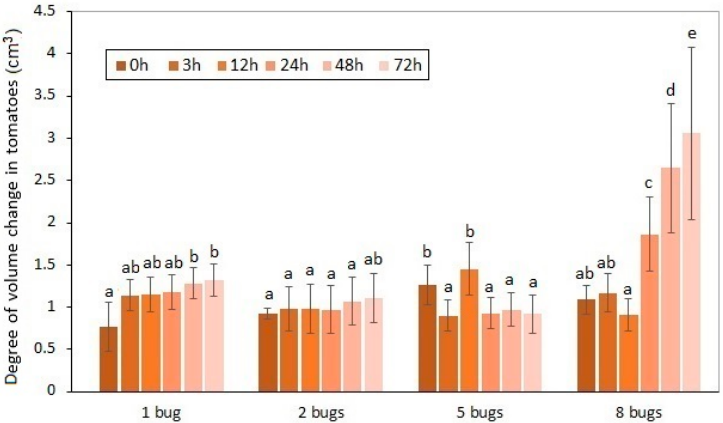
Figure 2. Volume decreasing of experimental tomatoes as a function of exposure time and the number of H. halys images. a, b, c, d, e: Small letters indicate a significant difference ( p ≤ 0.05) between means of different treatments.